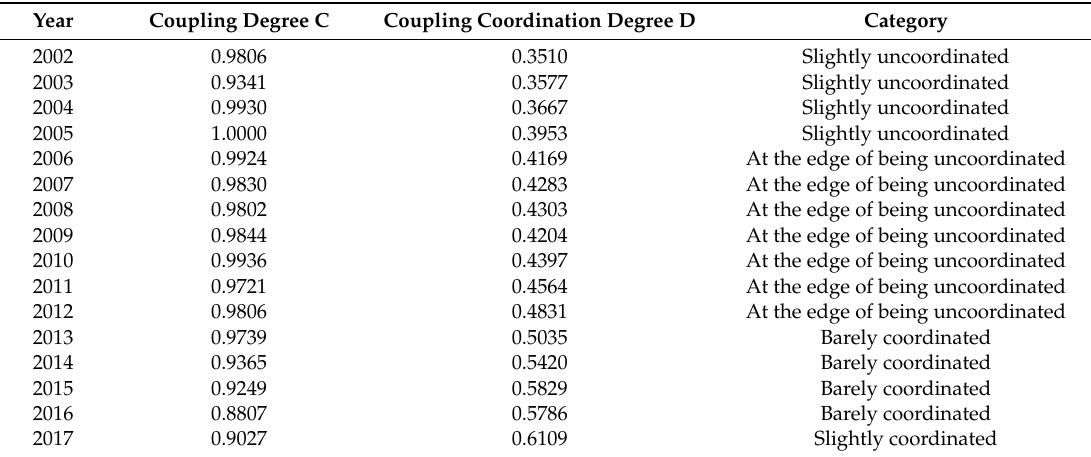
Table 5. The coupling coordination